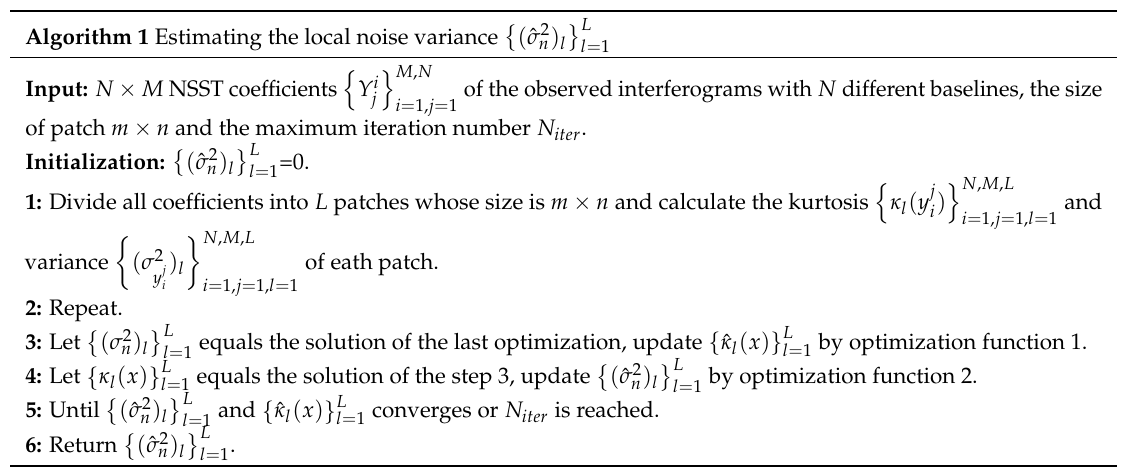
Algorithm 1 Estimating the local noise variance